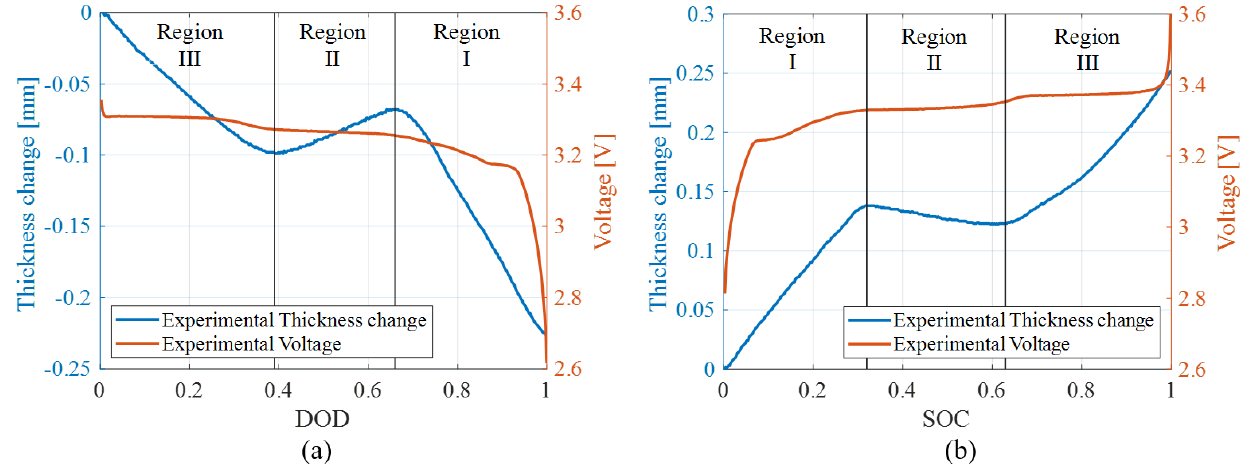
Figure 7. Thickness change and respective voltage during discharge ( a ) and charge ( b ) at